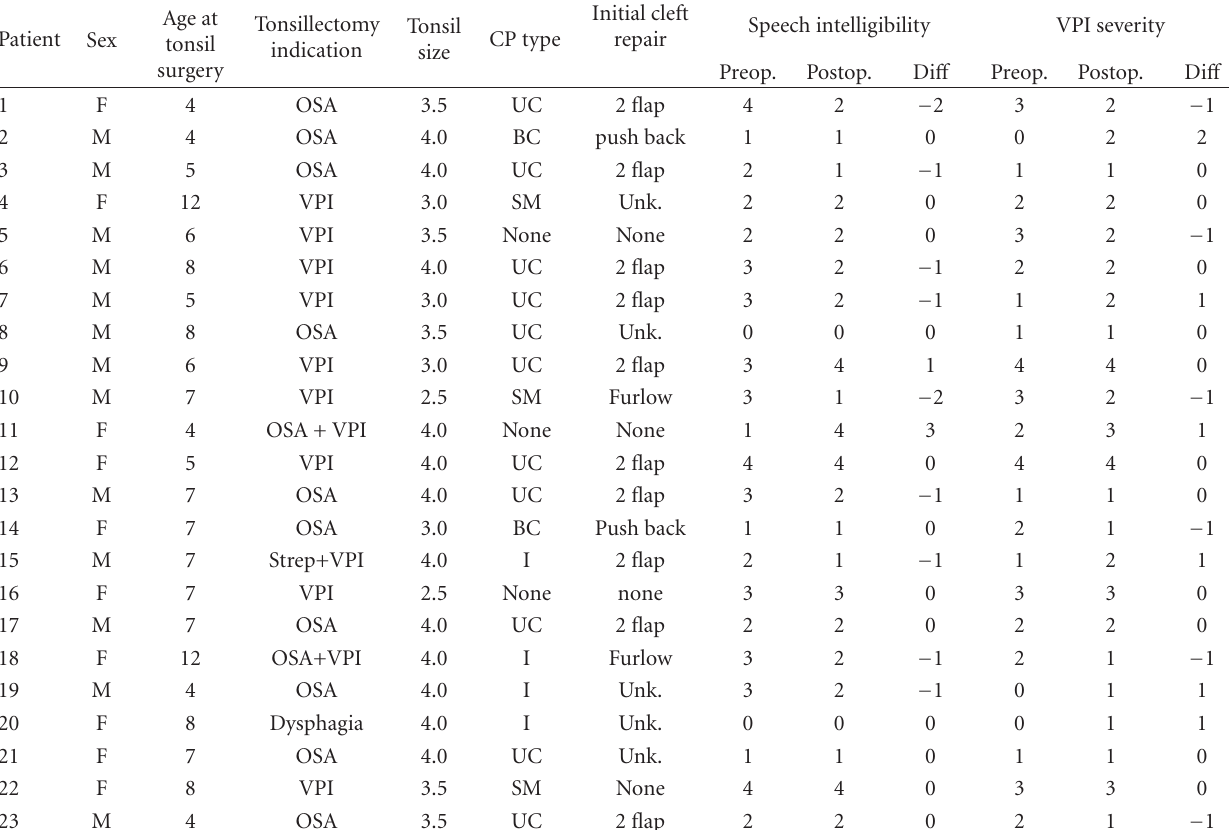
Table 1: Patient